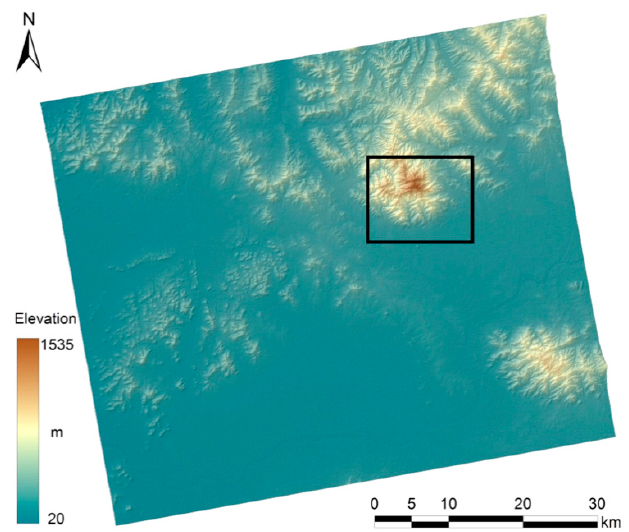
Figure 10. Hillshade of multi-baseline InSAR DEM. The black rectangle marks the coverage of the 1:25,000 DEM used for accuracy validation.